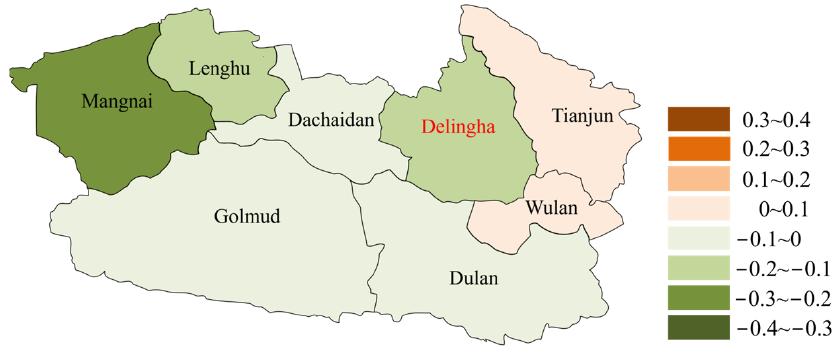
Figure 2. The Kendall correlation coe ffi cient of wind and solar in Haixi.